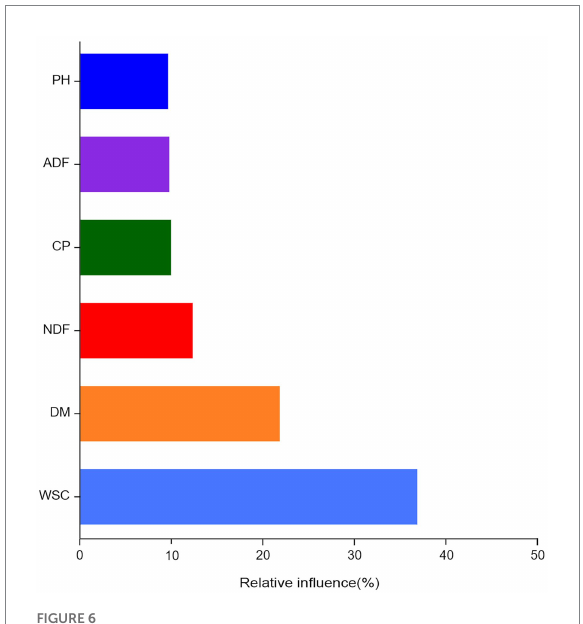
FIGURE 6 Aggregated boosted tree (ABT) analysis assessed the relative importance of fermentation quality and nutritional quality on bacterial community